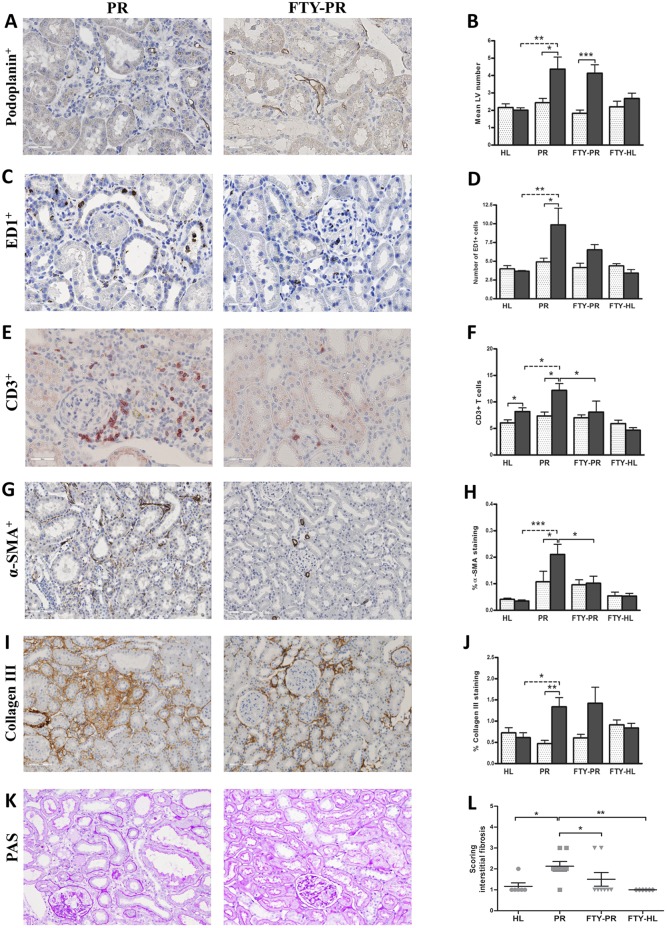
Effects of FTY720 treatment on renal lymphangiogenesis, inflammation and fibrosis. Quantification of the staining of kidneys from proteinuric rats treated with FTY720 did not show any effect on the increased number of LVs in proteinuric rats at week 12 (A,B). Although FTY720 did not show a significant effect on the influx of macrophages (C,D), it did show a complete blocking of T-cell influx at week 12 compared with the untreated proteinuric rats (E,F) and also of α-SMA-positive cells at 12 weeks (G,H), whereas it did not show a significant effect on collagen III deposition (I,J). Nevertheless, interstitial fibrosis (PAS scoring) revealed that FTY720 could markedly prevent the development of interstitial fibrosis in proteinuric rats compared with healthy controls at week 12 (K,L). White dotted bars represent week 6 before treatment; black bars represent week 12 after treatment. PAS staining and quantification has been done at week 12. HL, healthy; PR, proteinuric untreated; FTY, FTY720. *P<0.05, **P<0.01, ***P<0.001.